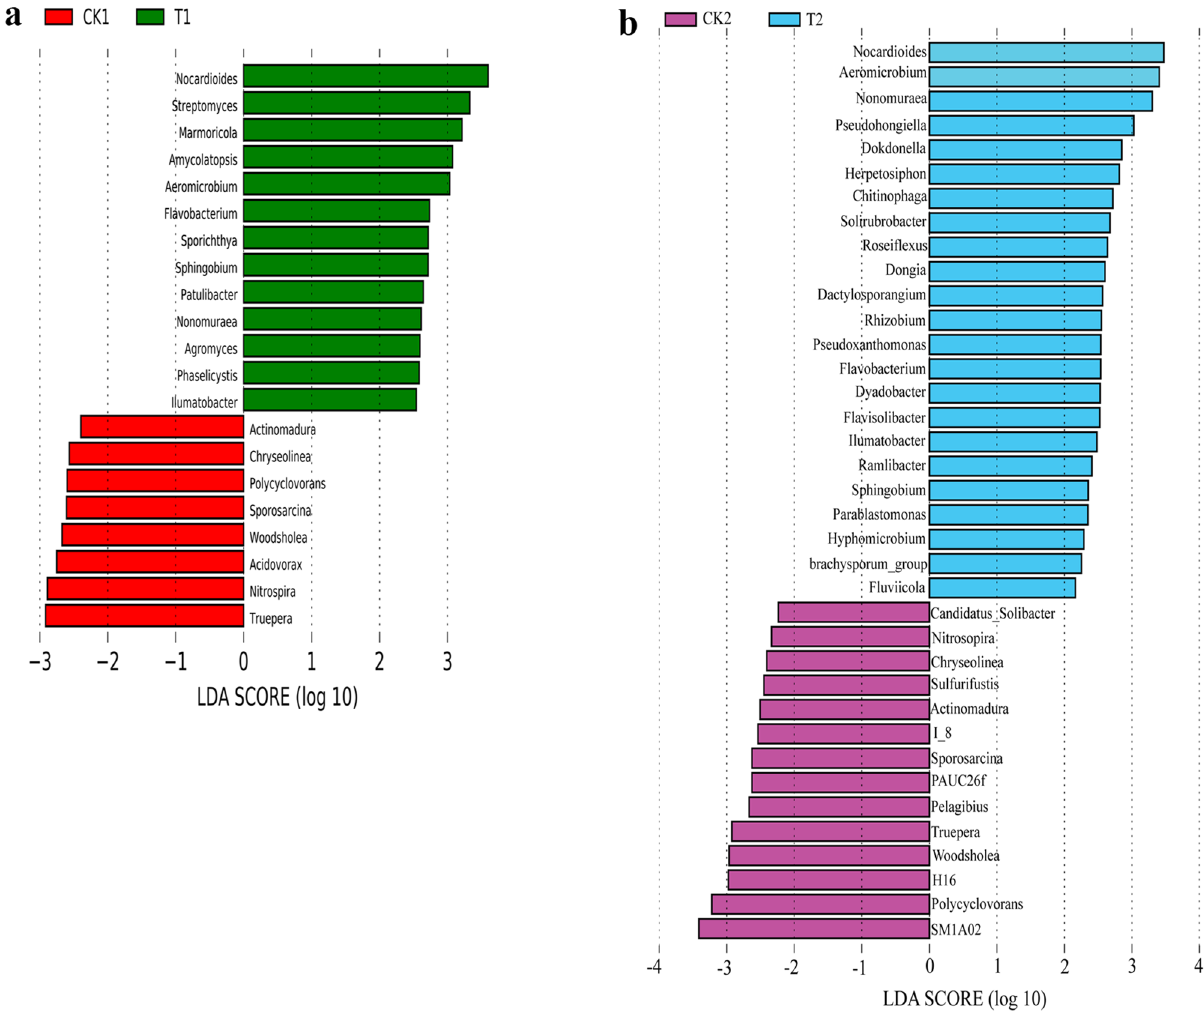
Figure 2. LDA histogram scores for bacterial genera with different abundance for the flowering stage ( a ) and fruiting stage ( b ) in the watermelon monoculture